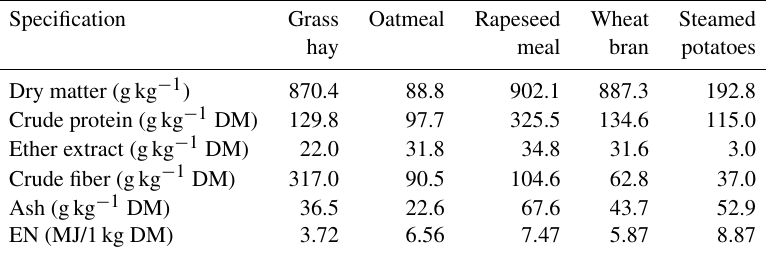
Table 1. The chemical composition and nutritional value of feeds used in lamb fattening. Specification Grass Oatmeal Rapeseed Wheat Steamed hay